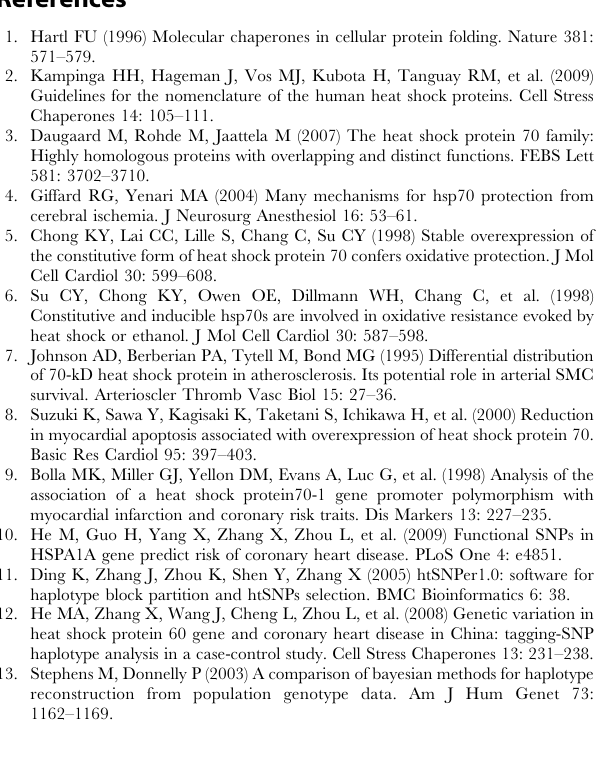
Table S2 Primers and probes for genotyping 4 TagSNPs in HSPA8 gene.